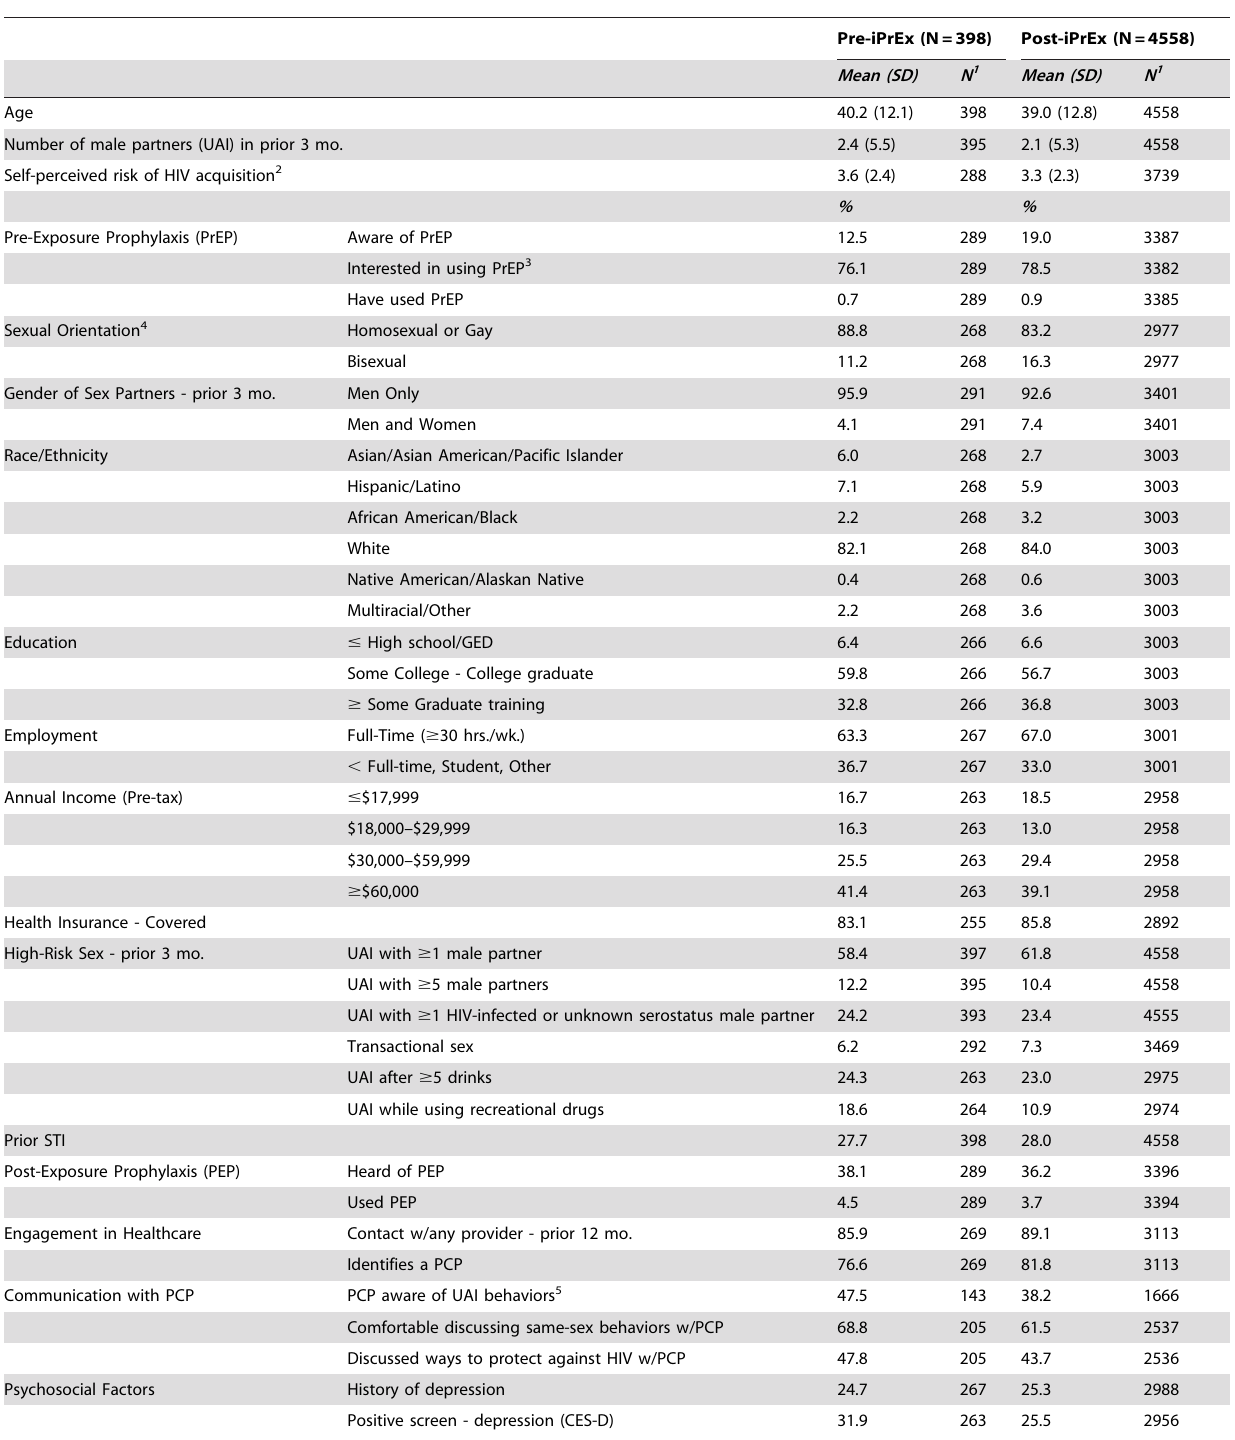
Table 1. Sociodemographic and Behavioral Characteristics of Study Participants Two Months before (n=398) versus One Month after (n= 4 558) Publication of Oral Pre-Exposure Prophylaxis Efficacy Results (the iPrEx Study).